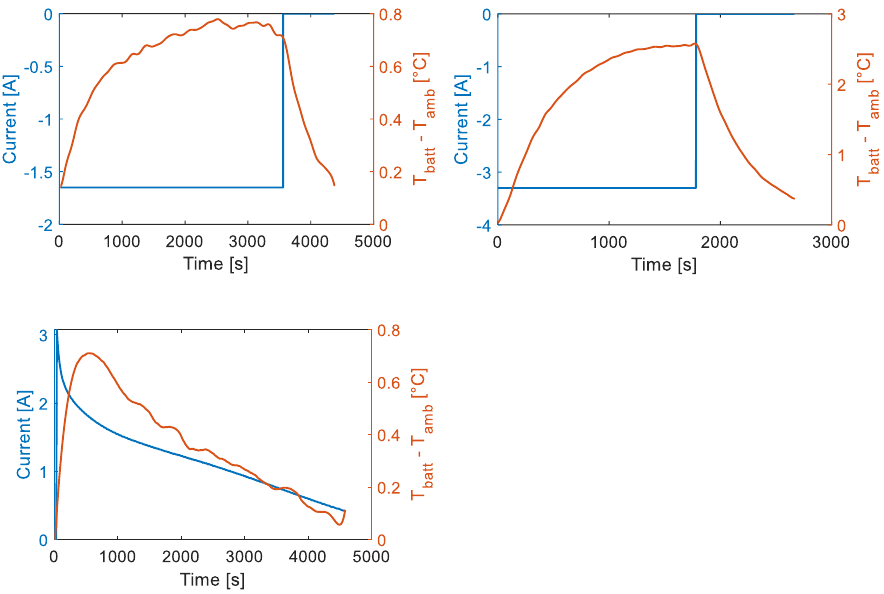
Figure 11. Transient of temperature and signal of current for the battery under discharge at different loads ( top ) and under charge ( bottom ).